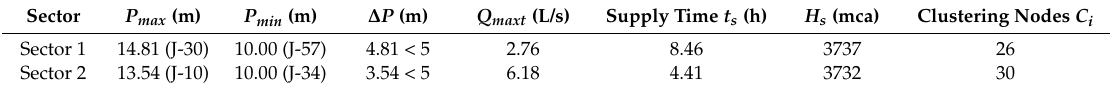
Table 7. Characteristics of the sectors after the sectorization process.